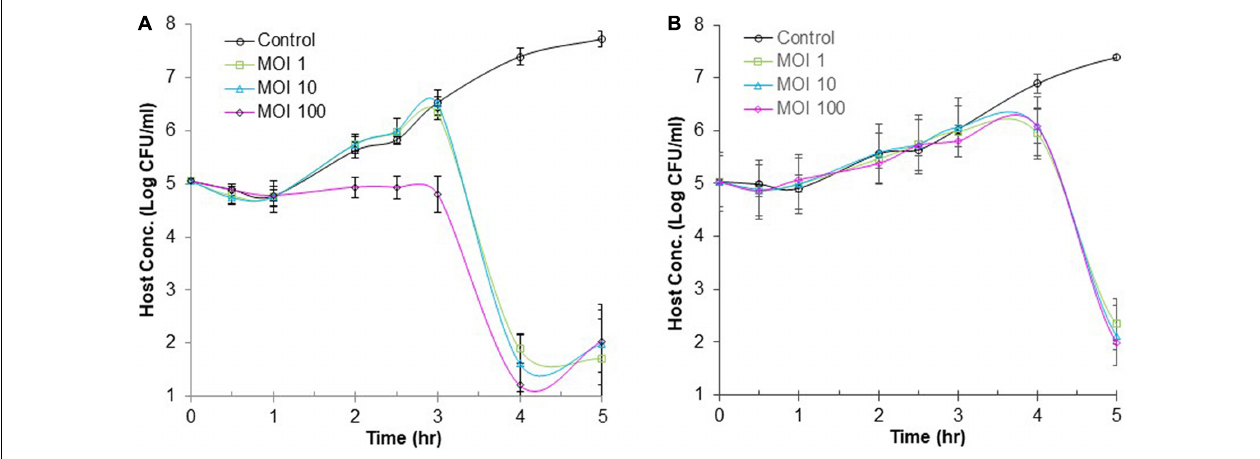
FIGURE 6 | Efficacy of phage infection by (cid:56) Ent against S. Thompson in cucumber juice (A) and beef broth (B) . Each point represents the mean ± standard error based on three measurements.